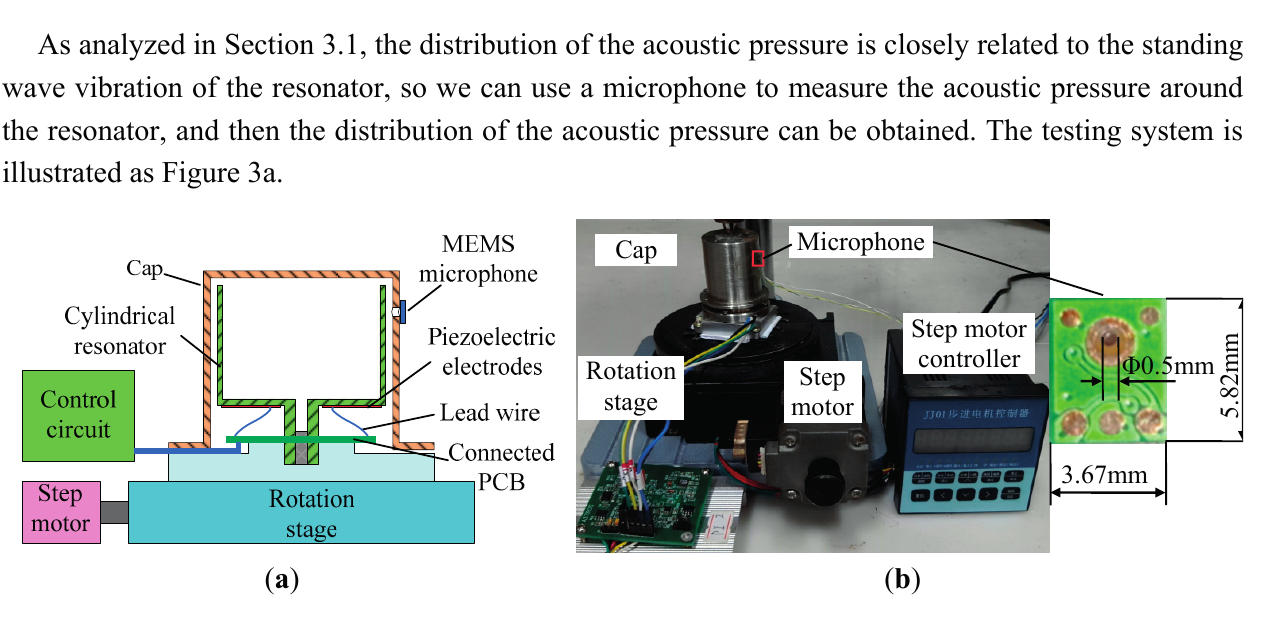
Figure 3. ( a ) Schematic of the testing system; ( b ) Photograph of the testing